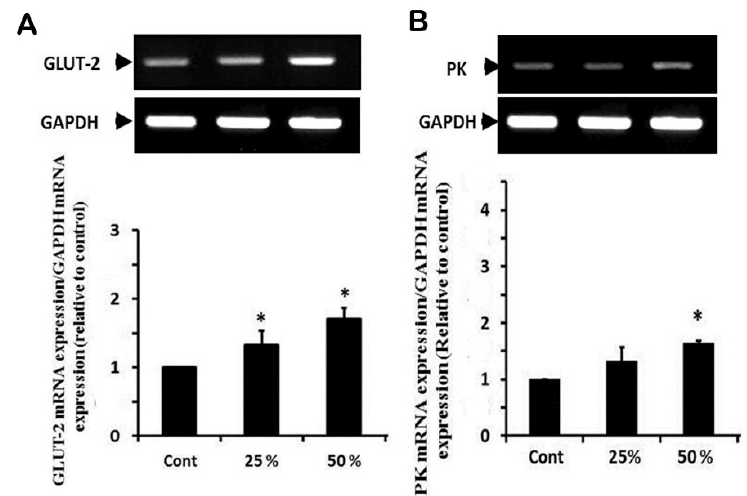
Figure 5. Effect of ginger water on GLUT-2 ( A ) and PK ( B ) mRNA expressions in the hepatic tissue of rats. Results of densitometric analyses and demonstrative blots of at least five independent experiments are displayed. Values are expressed as means ± SE. Cont: control, 25%:25% ( v / v ) ginger water-treated group, 50%:50% ( v / v ) ginger water-treated group. * p < 0.05 vs. the control.